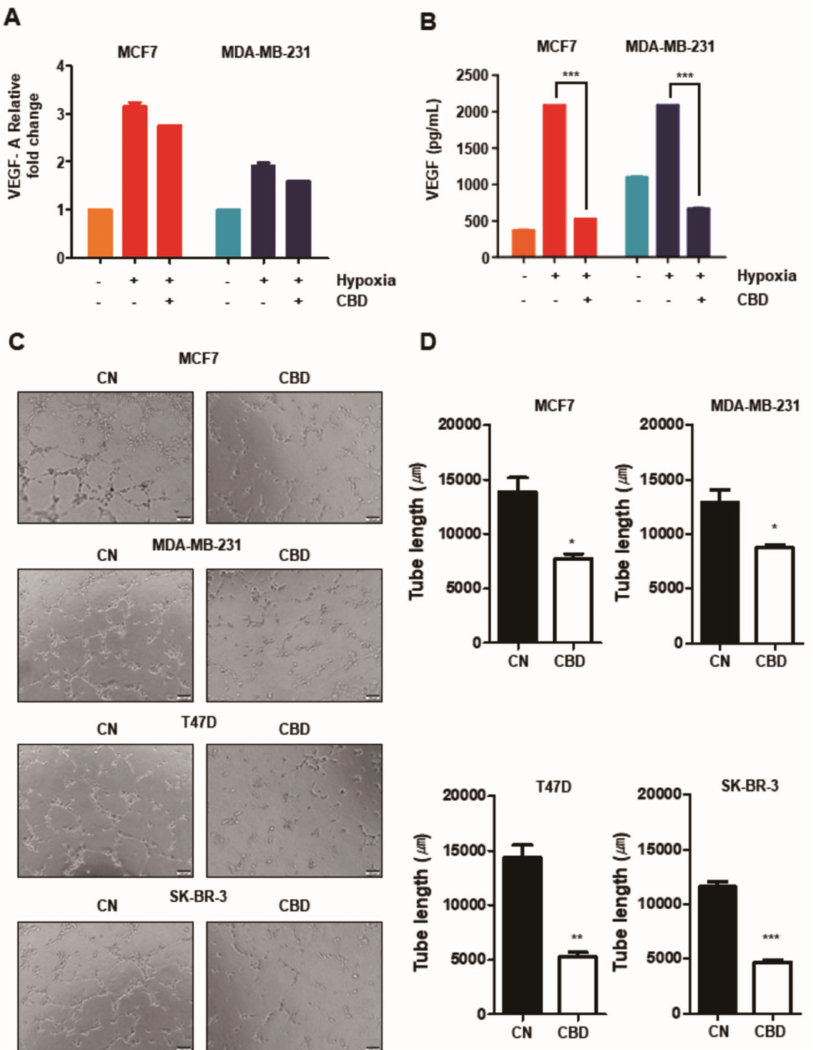
Figure 4. CBD inhibits angiogenic potential in breast cancer cell lines. ( A ) MCF7 and MDA-MB-231 cells were treated with CBD (2 µ M) in hypoxia. The total mRNA level of VEGF was analyzed by performing qRT-PCR. ( B ) The amount of secreted VEGF protein in MCF7 and MDA-MB-231 cells was analyzed by ELISA Kit. ***, p < 0.001 ( C ) The angiogenic potential was determined by HUVEC tube-formation assay. Conditioned media was collected from the breast cancer cell lines in hypoxia. Early-passage HUVECs were grown on matrigel-coated 48-well plates with conditioned media for 6 h. Capillary tube formation in each well was captured using a light microscope. ( D ) Total tube length was quantified using the ImageJ program. *, **, and *** indicate p < 0.05, p < 0.01, and p < 0.001 CBD; cannabidiol, CN;